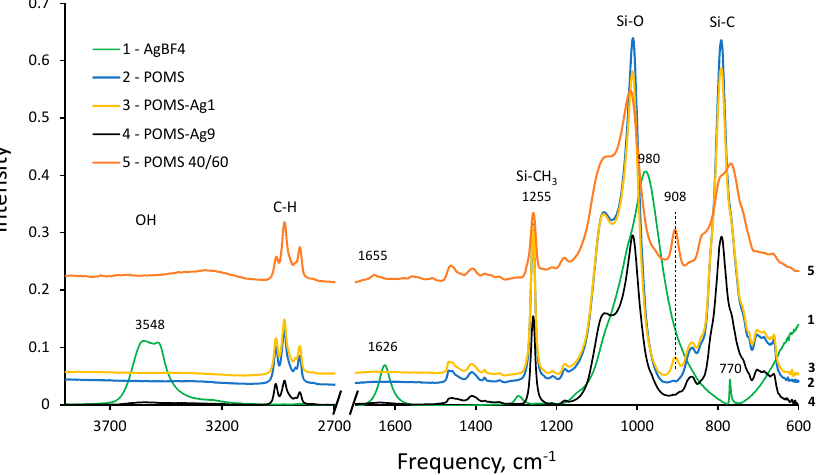
Figure 5. FTIR-spectra: 1, AgBF 4 ; 2, POMS; 3, POMS-Ag1; 4, POMS-Ag9; 5, POMS 40:60. Adapted with permission from Ref. [45]. Copyright 2017, Pleiades Publishing, Ltd.